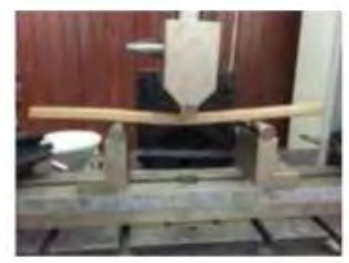
Figure 32. The Bending Procedures in the testing machine for span 220 mm (Author’s own, n.d.)